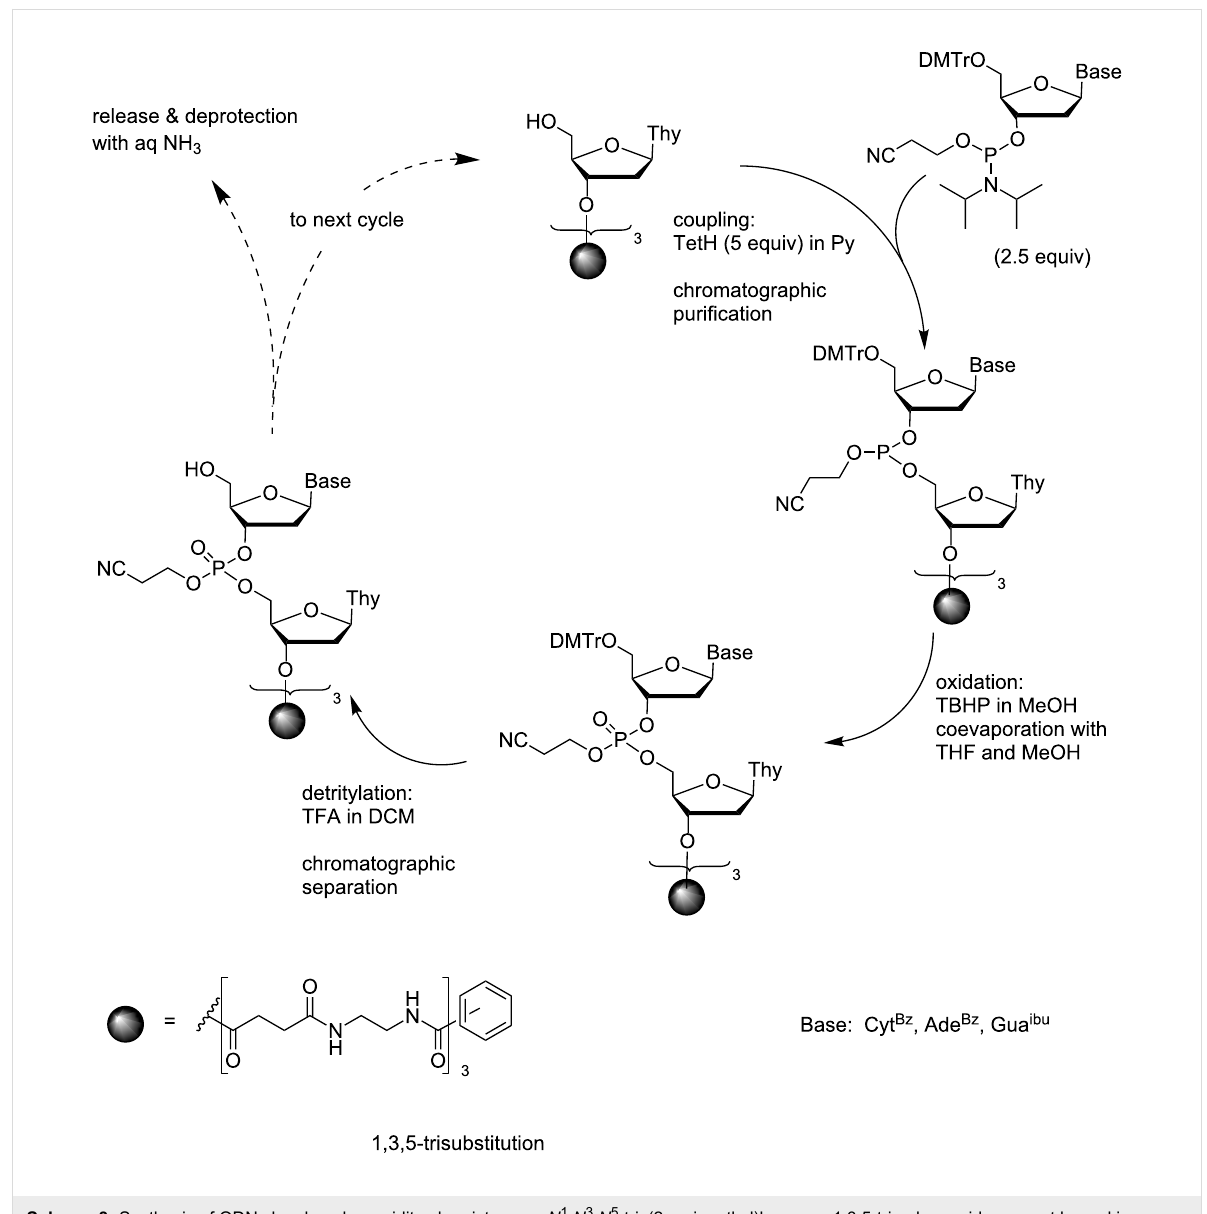
Scheme 8: Synthesis of ODNs by phosphoramidite chemistry on a N 1 , N 3 , N 5 -tris(2-aminoethyl)benzene-1,3,5-tricarboxamide support by making use of chromatographic separation